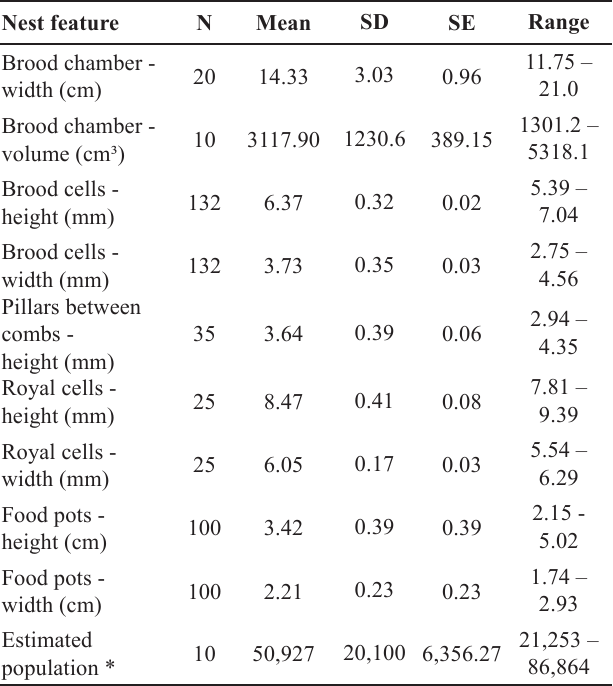
Table 1 . Internal nest features of Tetragona clavipes , Ribeirão